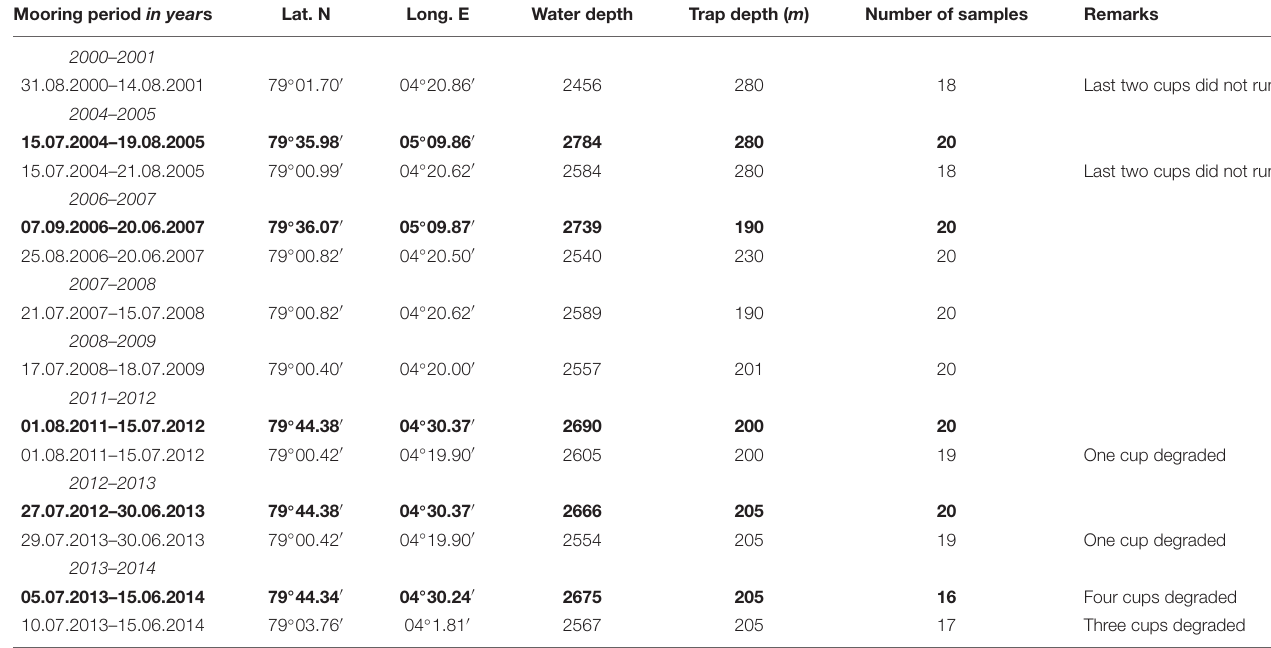
If deviations from the routine occurred, the respective information is given in the last column. A complete sample set consisted of 20 cups (Bold shows moored traps at the northern position, normal font represents the central HAUSGARTEN site, see also Figure 1 ). Degraded: Most of the sedimented material had disintegrated and was impossible to